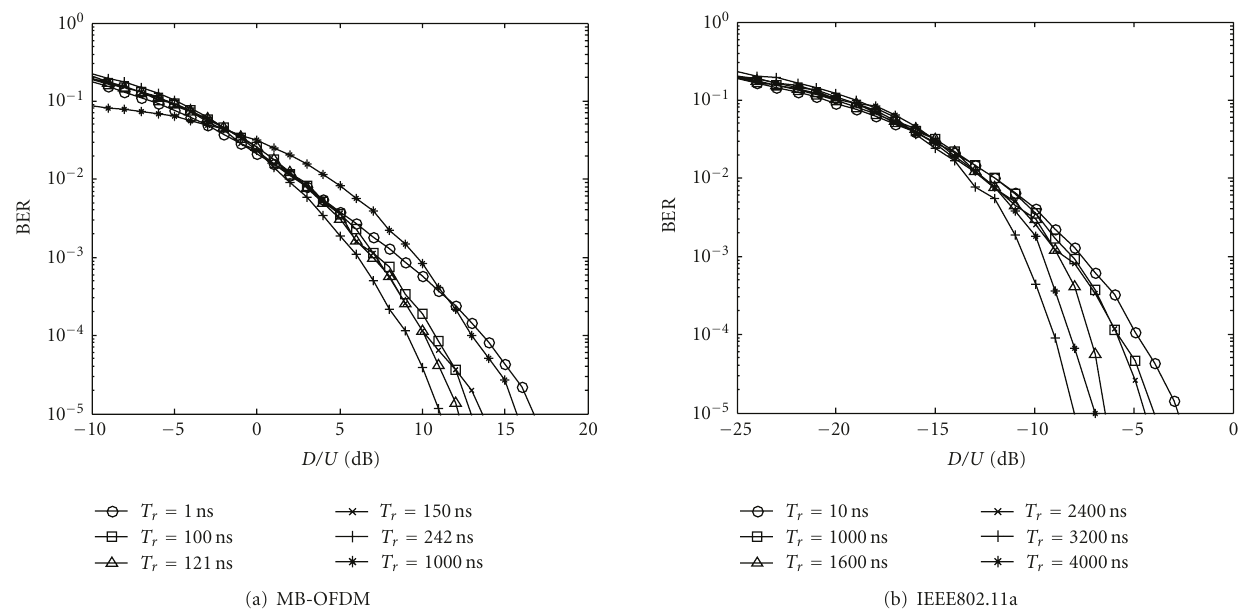
Figure 4: BER performance of OFDM interfered with by p-UWB in